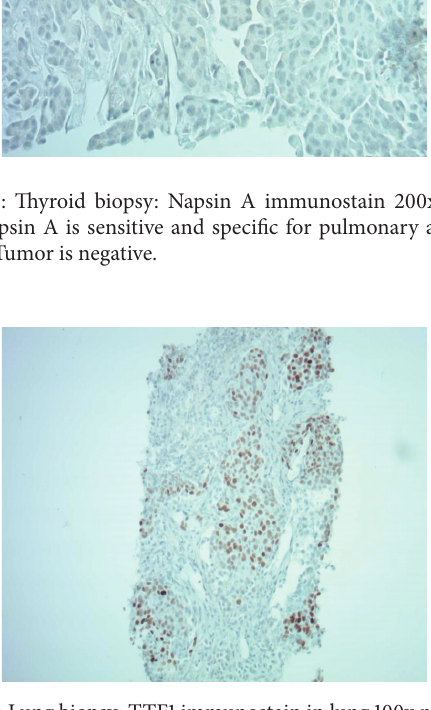
Figure 6: Lung biopsy: TTF1 immunostain in lung 100x magnifica- tion. Brown is positive in nucleus.